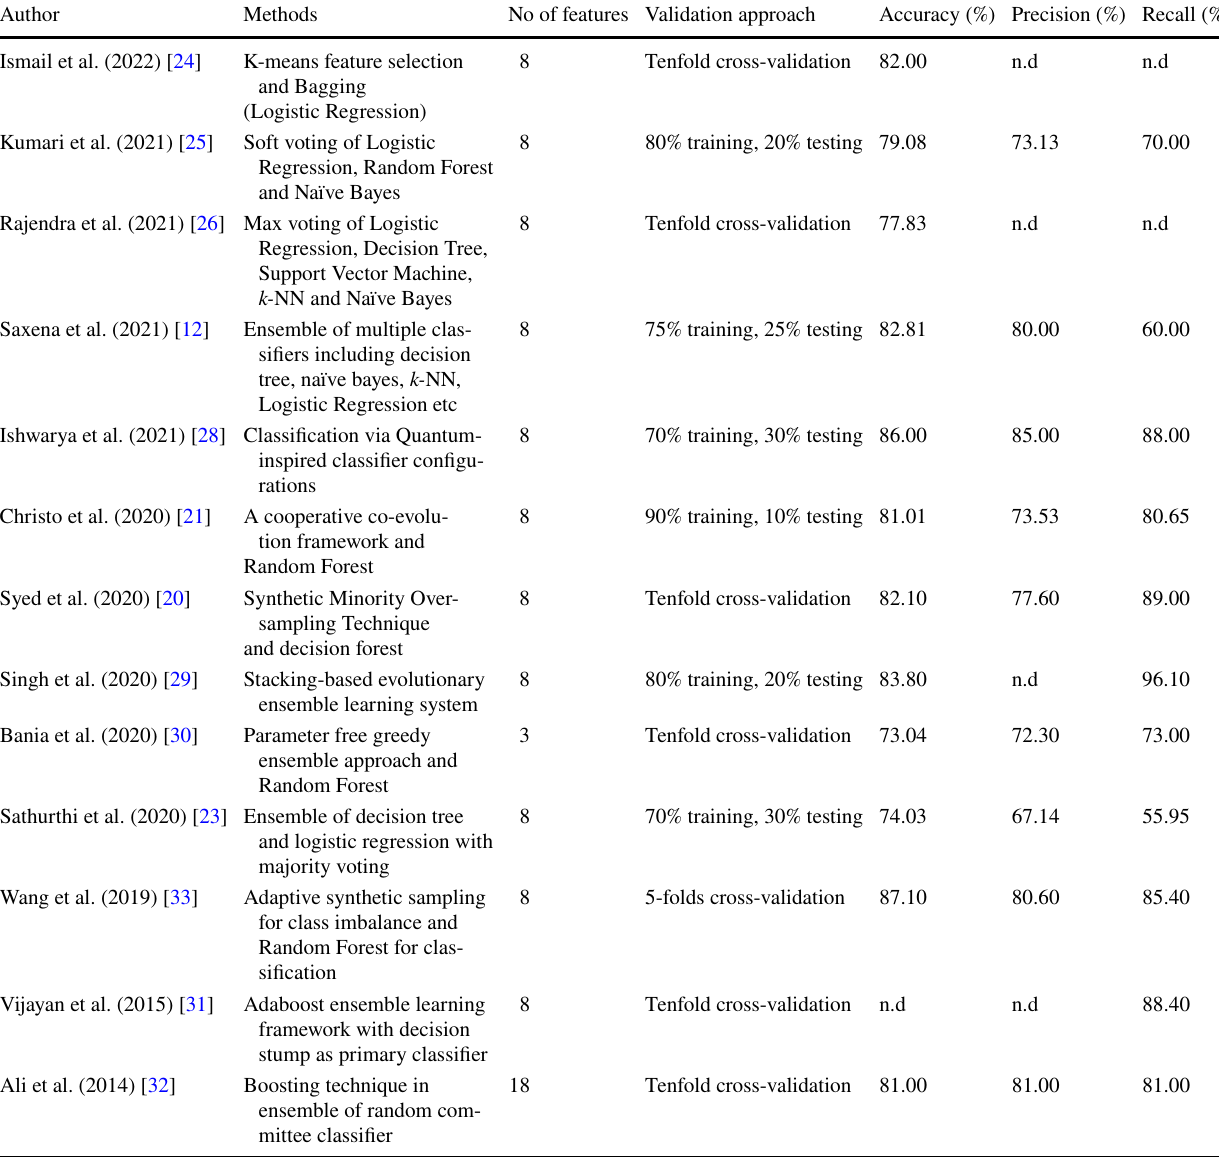
Table 1 Summary of literature review of various ensemble approaches for diabetes